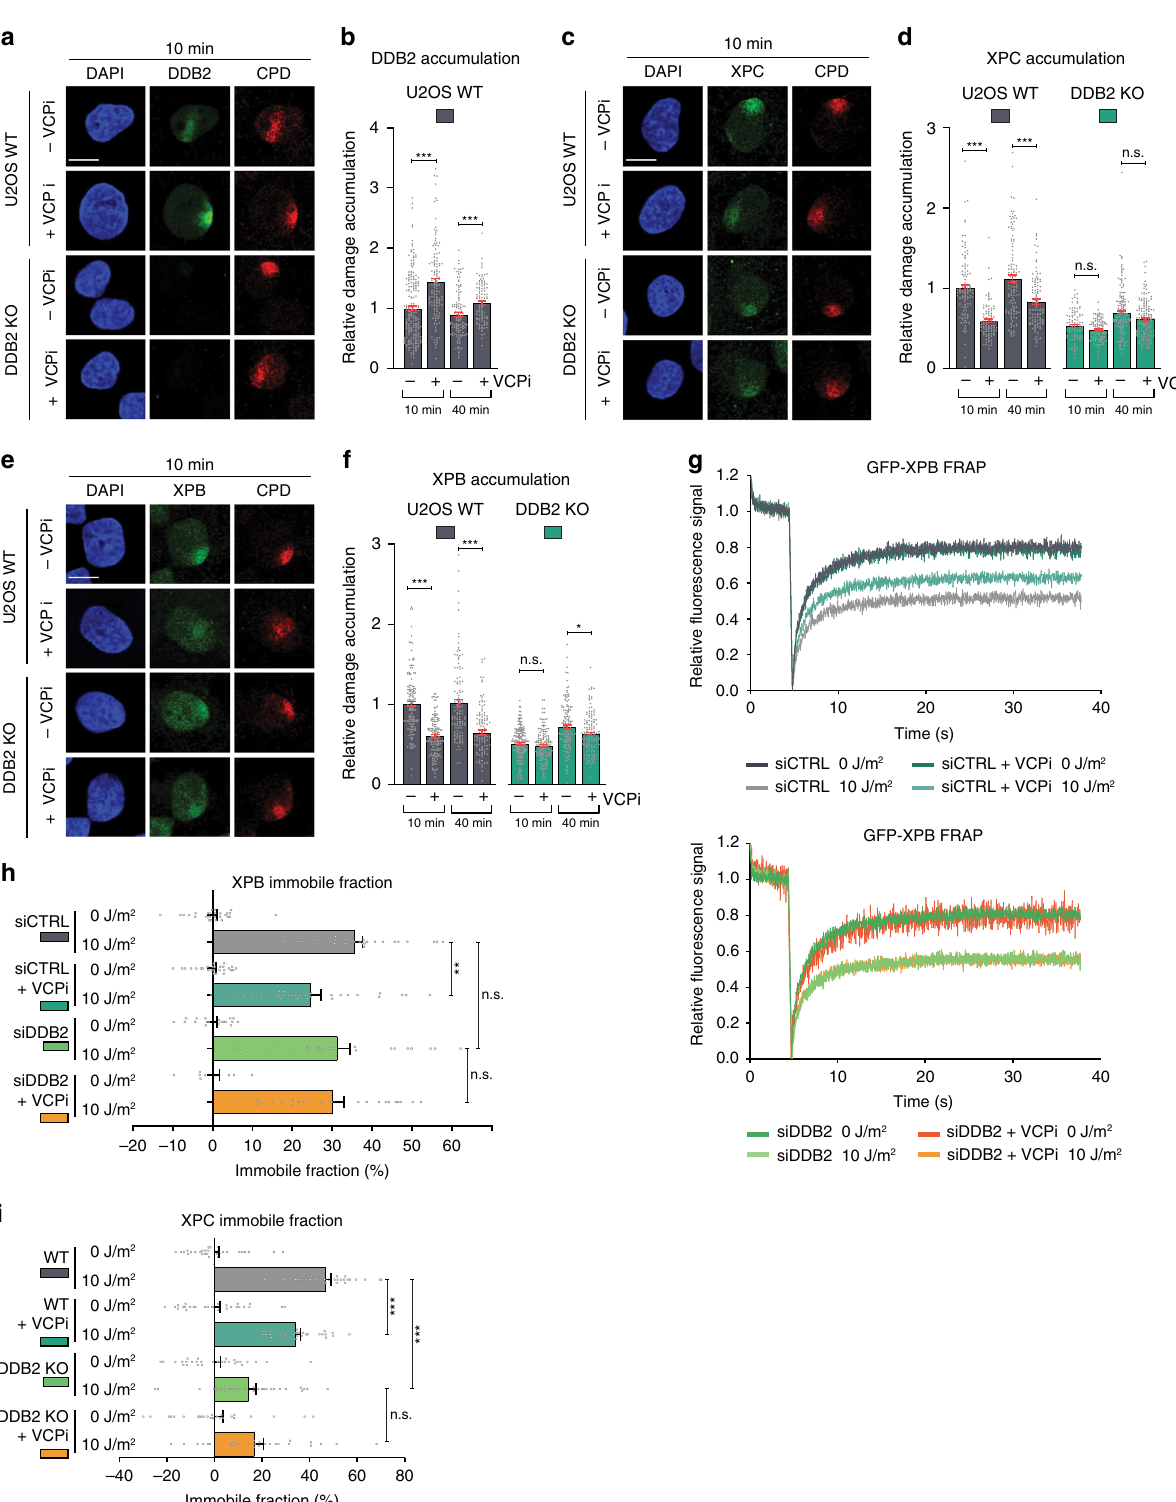
scenario in which the displacement of ubiquitylated DDB2 by VCP promotes damage handover to XPC and the formation of a stably bound damage veri fi cation complex together with TFIIH. Reciprocal coordination of DNA damage handover in GG- NER . We expected DDB2 to become more susceptible